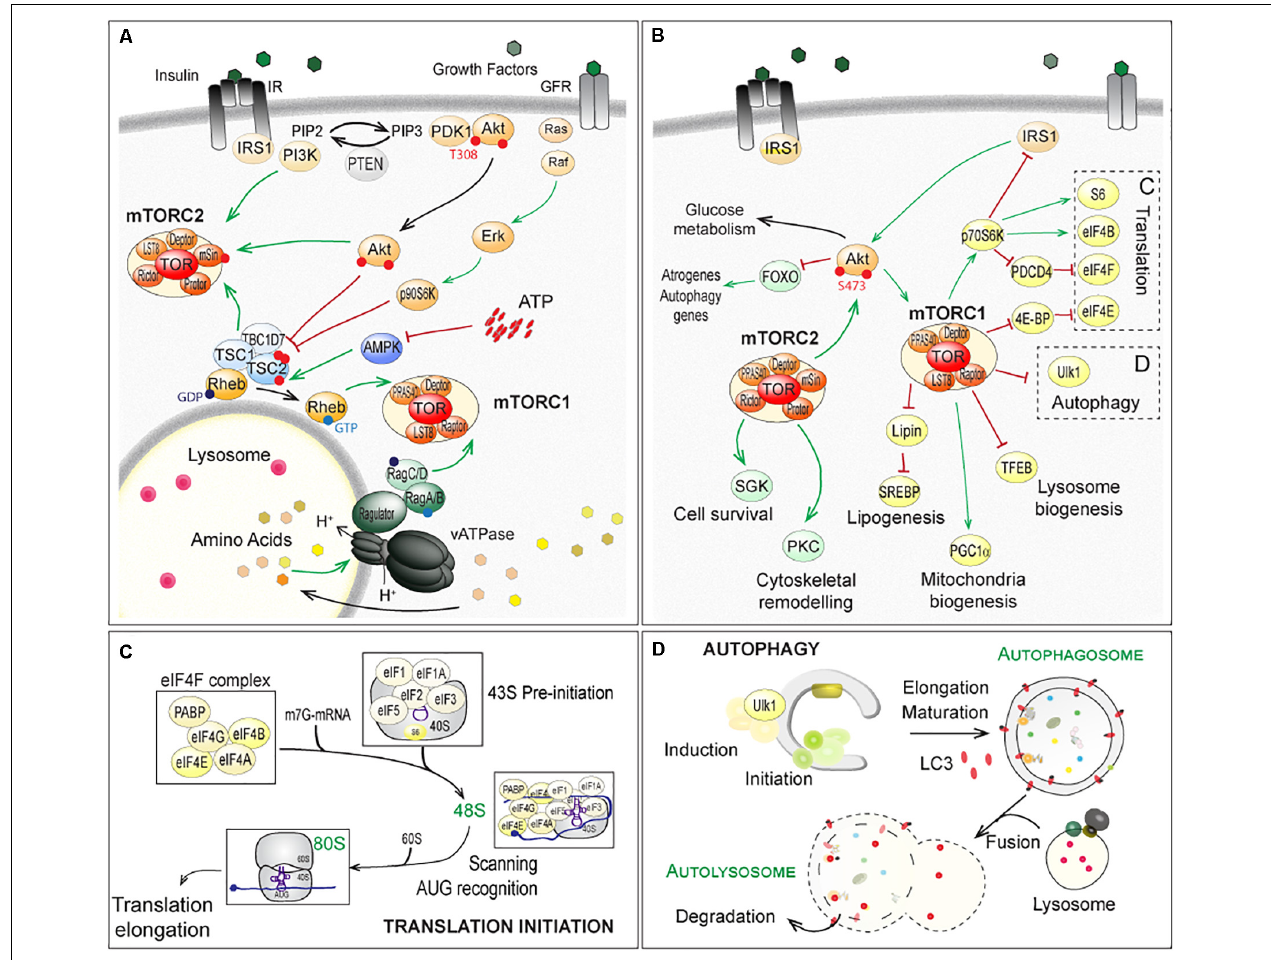
FIGURE 2 | Regulation of (m)TOR pathways and downstream factors and processes in fly and mammals. (A) Up-stream mechanisms regulating the (m)TOR-associated complex (m)TORC1 and (m)TORC2. Extracellular stimuli, nutrients and energy contribute to the regulation of mTORC1, at the lysosome. Growth factors, such as insulin, activate PKB/Akt, via the recruitment of IRS1 and PI3K and the formation of PIP3 ( PhosphatidylInositide-3,4,5-triPhosphate ). Active PKB/Akt destabilizes the complex formed by TSC1, TSC2 and TBC1D7, which releases Rheb and in turn activates (m)TORC1. Similarly, ERKs ( Extracellular signal-Regulated Kinases ) and p90S6K ( p90 ribosomal S6 Kinase , also known as MAPK-activated protein kinase-1 ) phosphorylate TSC2 and activate (m)TORC1, in response to growth factors (Ma et al., 2005; Roux et al., 2007). Amino acids activate the vacuolar proton pomp v-ATPase, which acidifies lysosome and promotes GTP or GDP loading on Rag proteins. Interaction of Raptor with GTP-bound RagA/B and GDP-bound RagC/D leads to the activation of (m)TORC1 after its recruitment at the lysosomal membrane (Kim et al., 2008; Sancak et al., 2010; Zoncu et al., 2011; Bar-Peled et al., 2012). AMPK ( AMP -activated Kinase ) inhibits (m)TORC1 by phosphorylating Raptor (Gwinn et al., 2008) and TSC2 (Inoki et al., 2006), in response to a lowering of cellular energy ( i.e. AMP/ATP levels). PI3K, PKB/Akt and TSC1/TSC2 complex activate mTORC2. (B–D) Downstream effectors of (m)TORC1 and (m)TORC2, with special focus on translation initiation (C) and autophagy (D) , both mainly controlled by (m)TORC1. Note that mTORC1 indirectly inhibits PKB/Akt and mTORC2, via p70S6K and the degradation of IRS1. In contrast, mTORC2 promotes mTORC1, by activating PKB/Akt. Red lines indicate inhibition; Green arrows represent activation. TFEB, Transcription factor EB; SREBP, Sterol regulatory element-binding proteins; PGC1 α , Peroxisome proliferator-activated receptor gamma coactivator 1-alpha. The other abbreviations are included in the